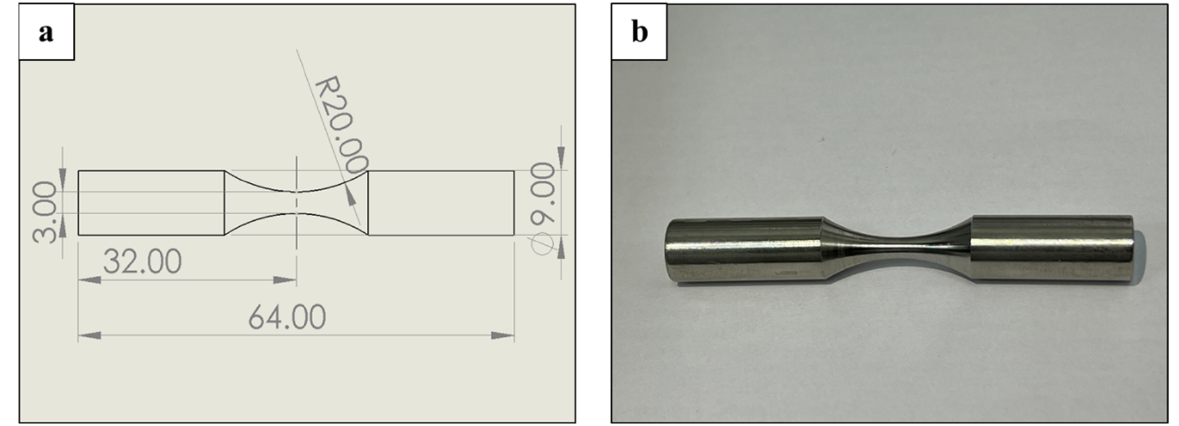
Figure 1. Description of the fatigue specimen. ( a ) Dimensions of the specimen. ( b ) Photo of the specimen.